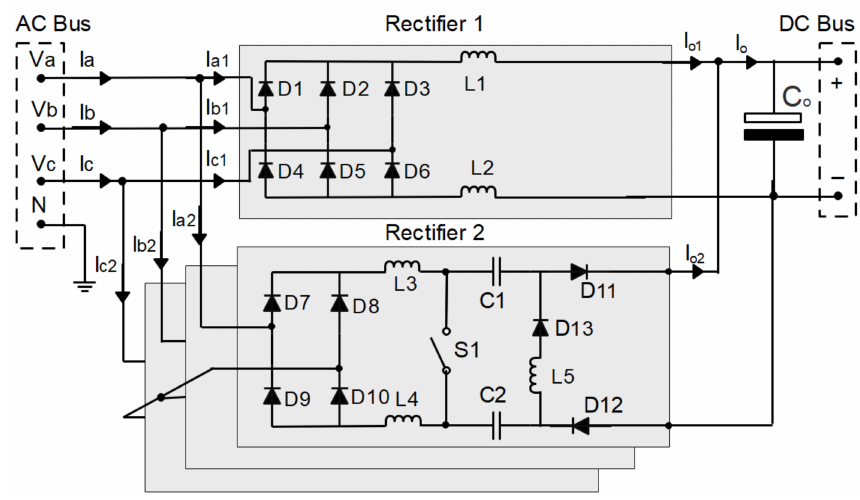
Figure 21. Configuration of the electrical circuit of UHTR-R1//SR2.